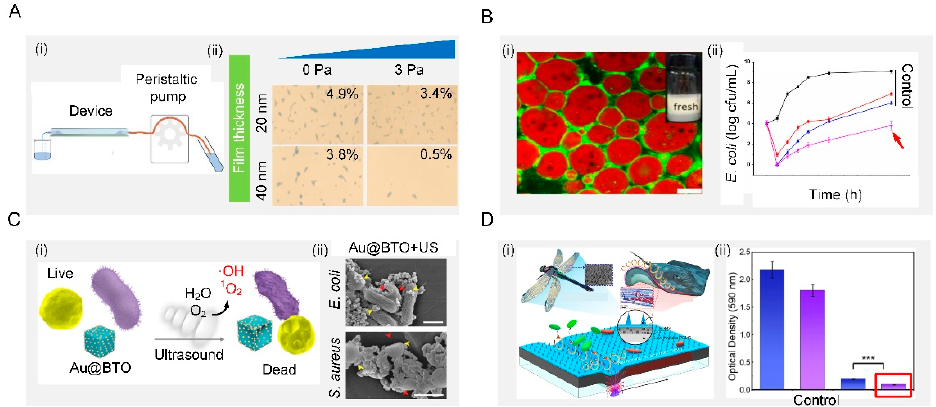
Figure 7. Active removal. ( A ) Shear removal. Schematic illustration of the process of bacterial adhesion strength assay in the microfluidic device. After pre-seed of S. aureus in a microfluidic device, many bacterial cells detached from the C-40 surface under the same shear stress. Reproduced with permission [154]. 2016, Royal Society of Chemistry. ( B ) Interfacial tension. Schematic illustration of fresh Pickering emulsions. Effects of Zein/GA-thymol Pickering emulsions on the growth of E. coli. Reproduced with permission [156]. 2021, Elsevier. ( C ) Mechanical waves. Schematic diagram of sonodynamic bacterial elimination based on piezoelectric nanocomposite. Reproduced with permission [157]. 2021, Elsevier. ( D ) Dynamic actuating motions. Conceptual schematic of dynamic nanoneedle composites and long-term antibiofilm testing. Reproduced with permission [158]. 2021, Elsevier.